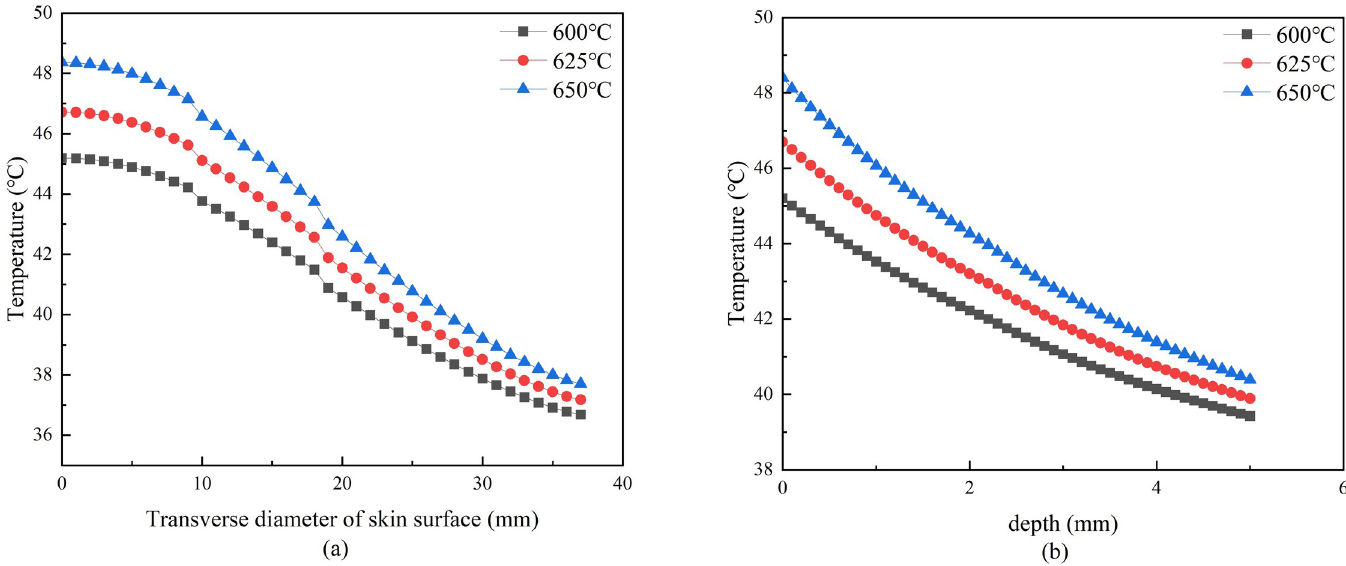
Fig 6. (a) Lateral skin temperature curve when moxa-burning temperature changes. (b) Vertical skin temperature curve when moxa-burning temperature changes. https://doi.org/10.1371/journal.pone.0282355.g006 3.1.3. Effect of the stick-to-skin distance on temperature distribution. Under the con- dition that the mild moxibustion time, moxa-burning temperature, moxa stick size, and skin moisture content were unchanged, the stick-to-skin distance was changed. Three distances were set, and the simulation was conducted to obtain the temperature distribution on and inside the skin surface after mild moxibustion, as shown in Figs 9 and 10. Fig 9 shows that the larger distance between the moxa stick and the skin, the lower the tem- perature on the skin surface and 5mm below the moxibustion point. During mild moxibus- tion, the skin surface temperature increases rapidly in the first 5 minutes, and gently in the